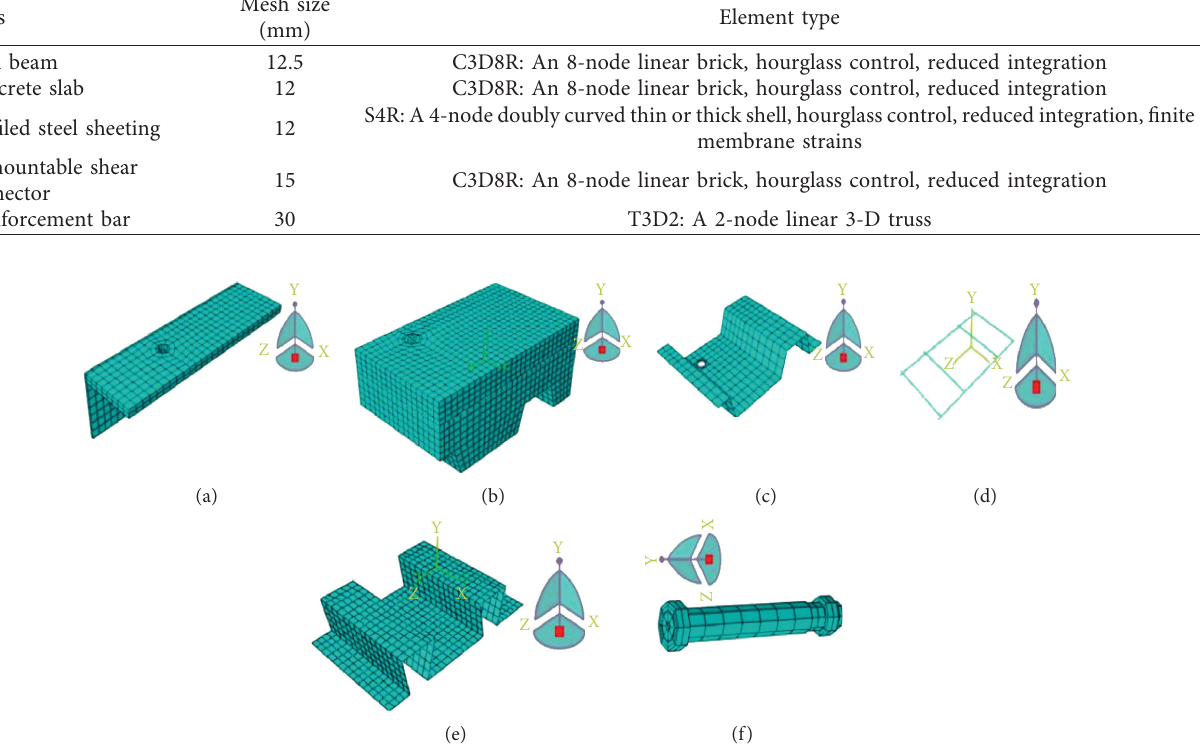
Figure 6: Meshing each part of the composite structure.